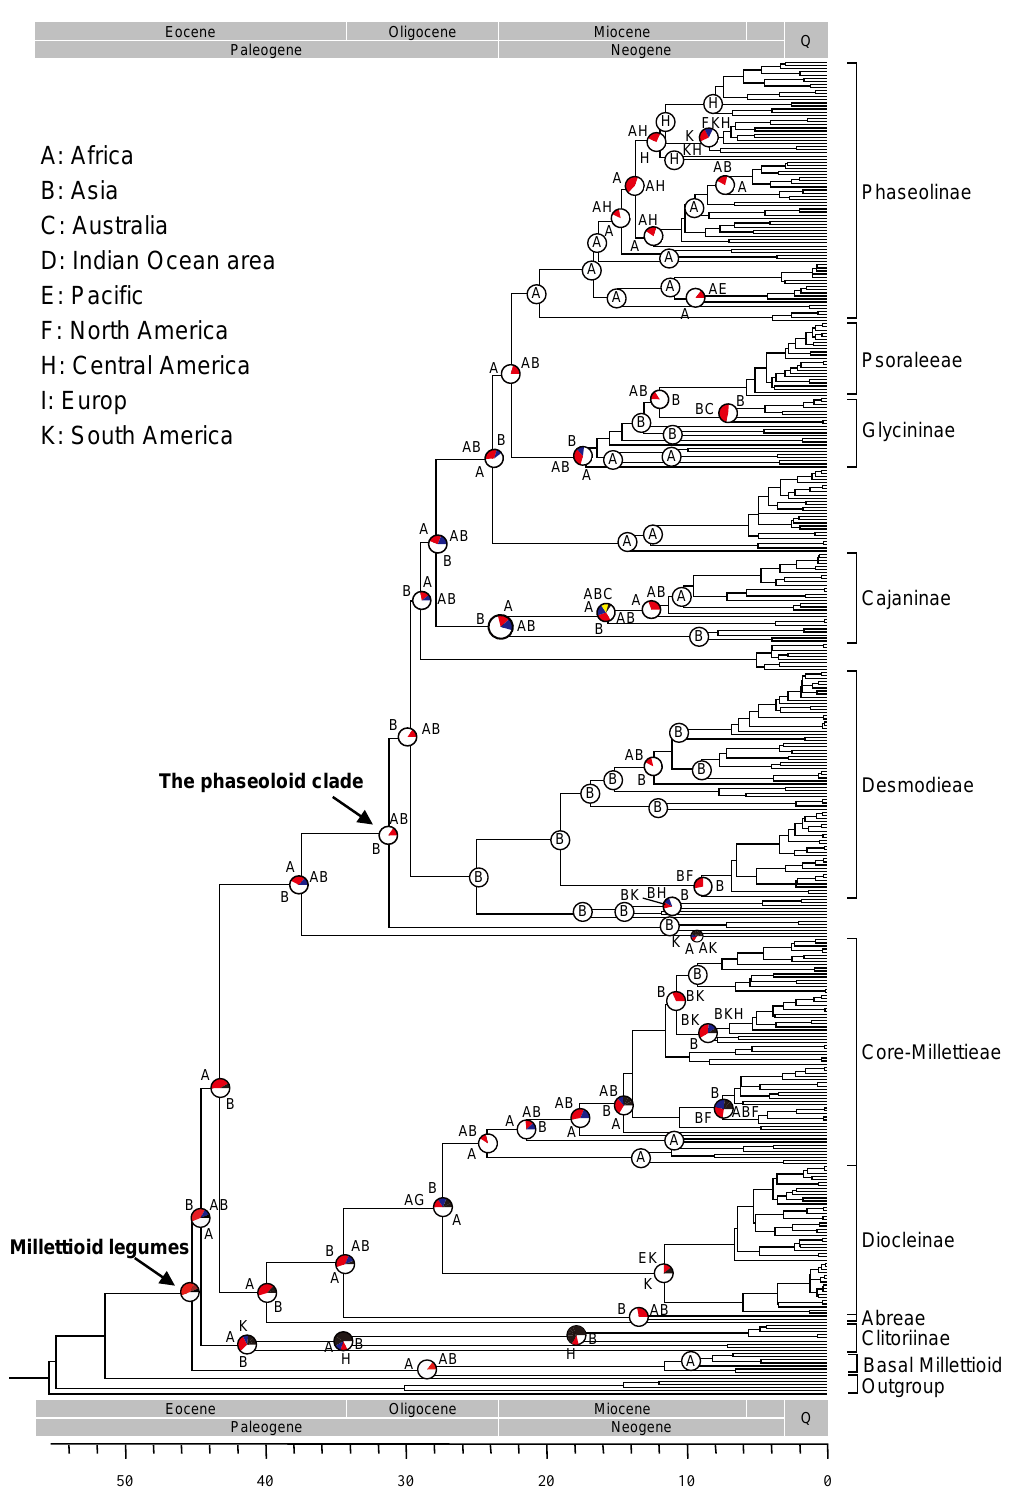
Figure 1. Combined chronogram and the summary of biogeographic analysis of the Millettiod legumes. Dating analysis was performed using BEAST software. The topology corresponds to the majority rule consensus tree of the Bayesian stationary sample. Large pie charts show the relative probabilities of alternative ancestral distributions obtained by statistical dispersal–vicariance analysis (white > red > blue > yellow); areas (frequencies < 0.1) are collectively given with black